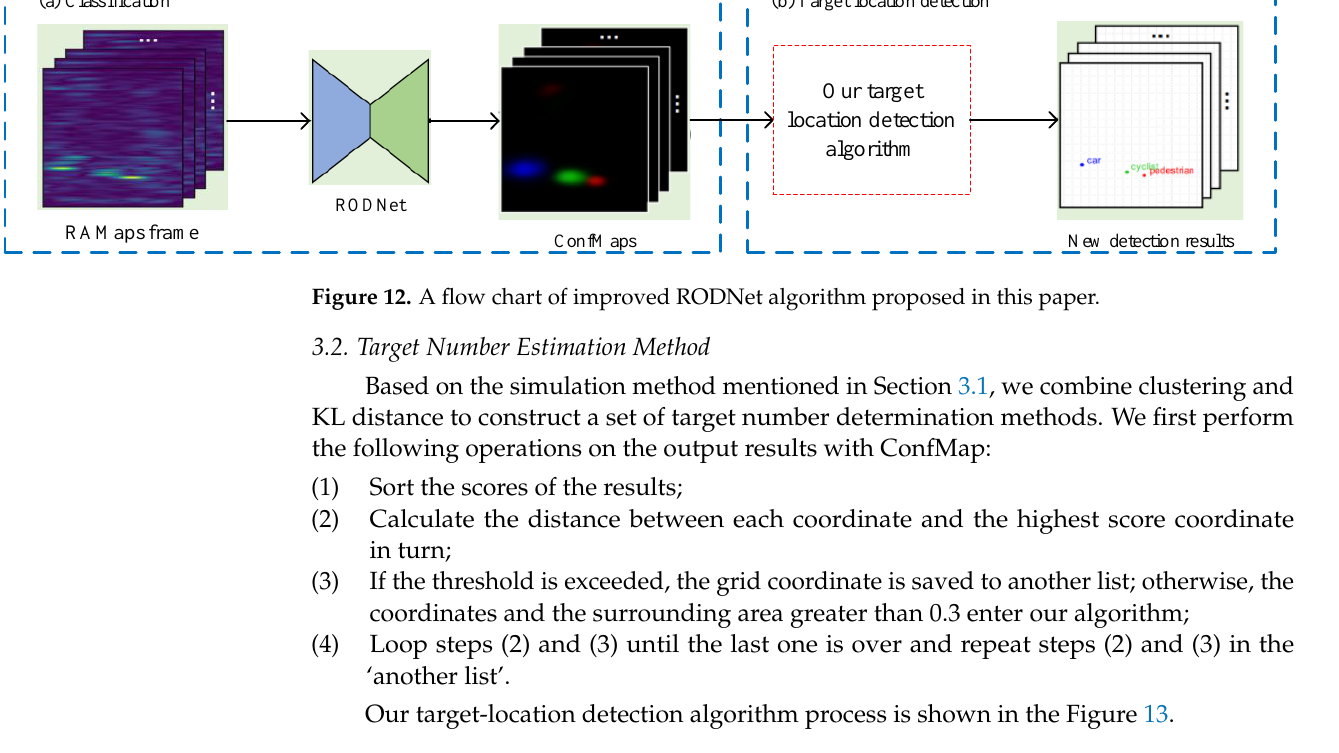
Figure 12. A flow chart of improved RODNet algorithm proposed in this paper.